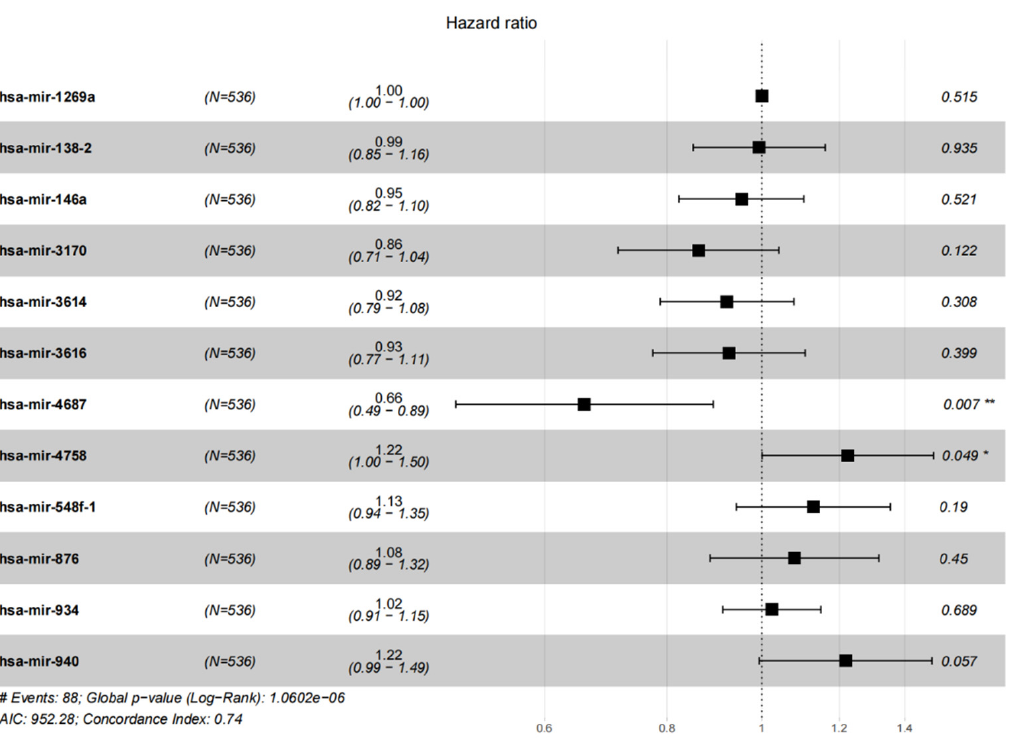
Figure 3. Multivariate COX analysis was used to verify 12 miRNAs related to EC patients. *: p < 0.05; **: p < 0.01.